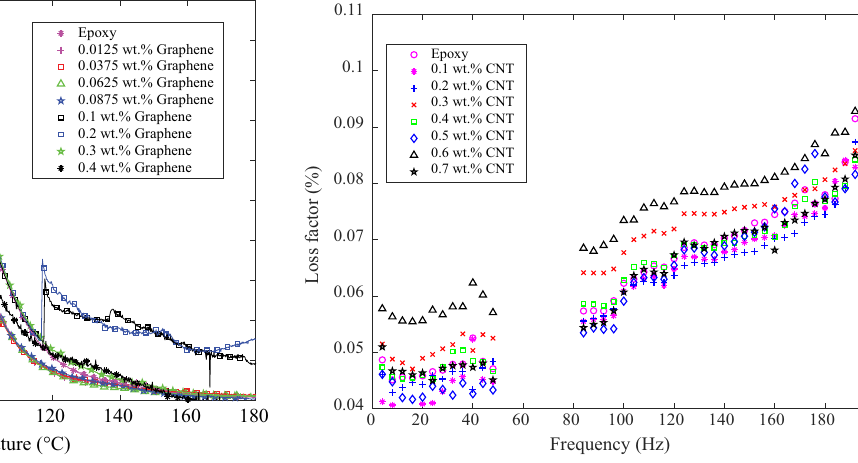
Figure 6: Temperature - dependent loss factor of GNP - reinforced composites by DMA